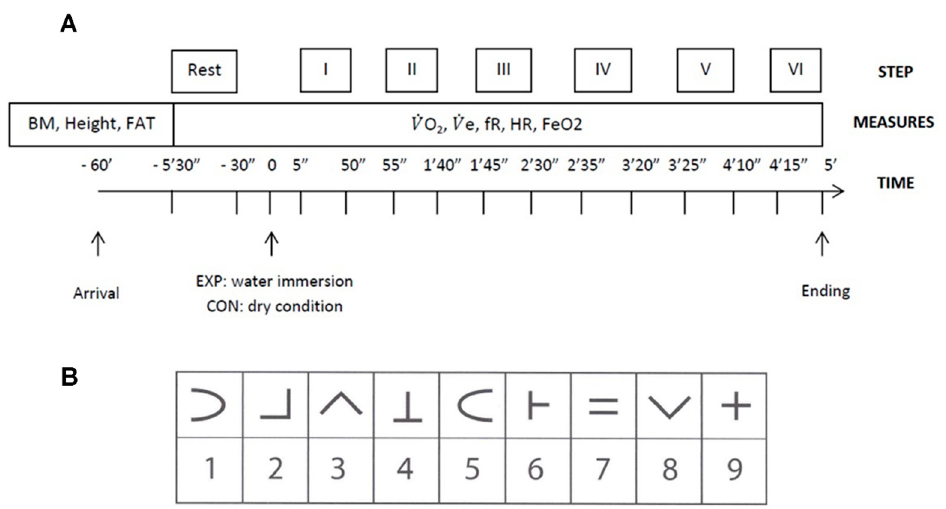
Figure 1. Timeline of the experimental session, including ( A ) the Step sequences and ( B ) an example of the SDMT matrix. Note: The full SDMT test depicts a printed matrix on one sheet of paper that includes a random sequence of 45 symbols and blank squares. Each square is completed by the participant who either writes their answer into the square (on land), or verbally indicates their answer to the researcher, who immediately records the result (water